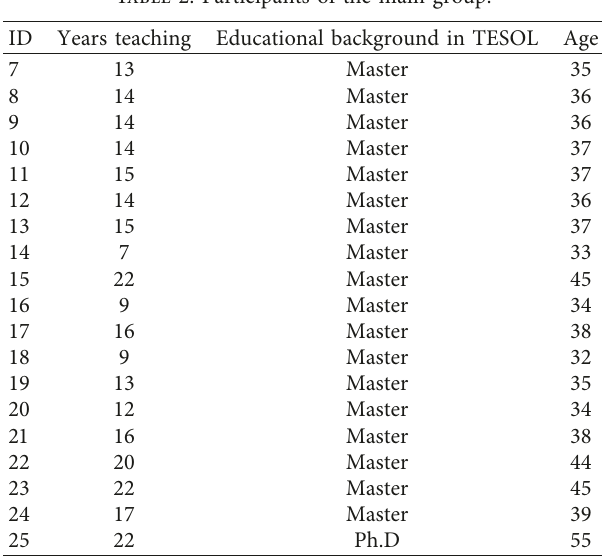
Table 2: Participants of the main